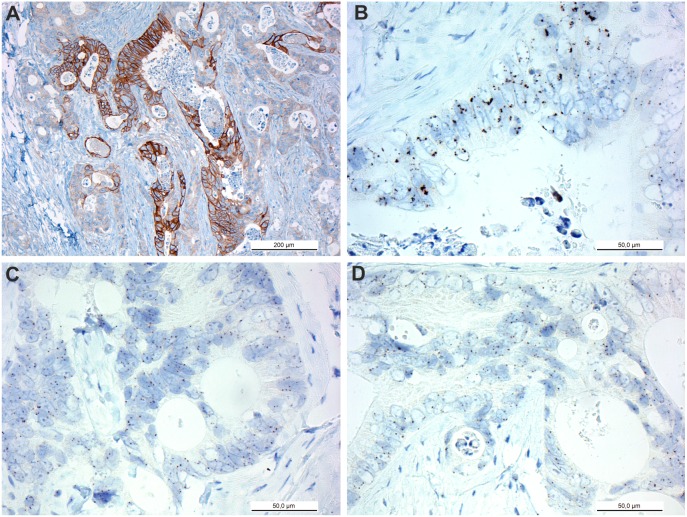
EGFR immunohistochemistry and EGFR silver in situ hybridization analysis in colorectal cancer.EGFR IHC shows heterogeneous staining with intensive membranous reactivity in the middle (a). EGFR SISH from the intensively stained area showing gene clusters (b). EGFR SISH from the surrounding areas with weak or negative EGFR IHC staining shows marginally elevated or normal gene copy numbers (c–d).